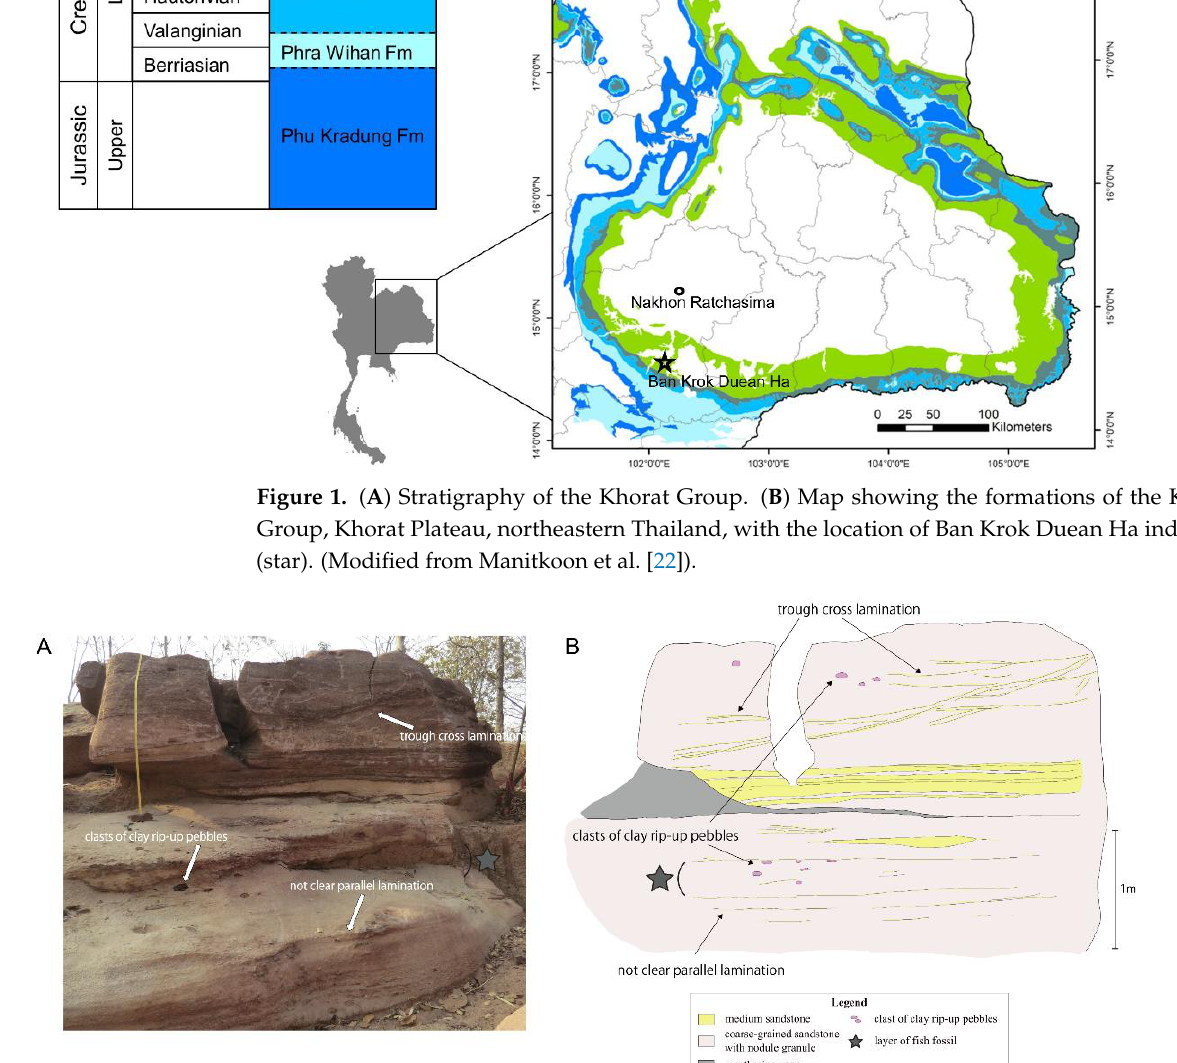
Figure 1. ( A ) Stratigraphy of the Khorat Group. ( B ) Map showing the formations of the Khorat Group, Khorat Plateau, northeastern Thailand, with the location of Ban Krok Duean Ha indicated (star). (Modified from Manitkoon et al., [22]).